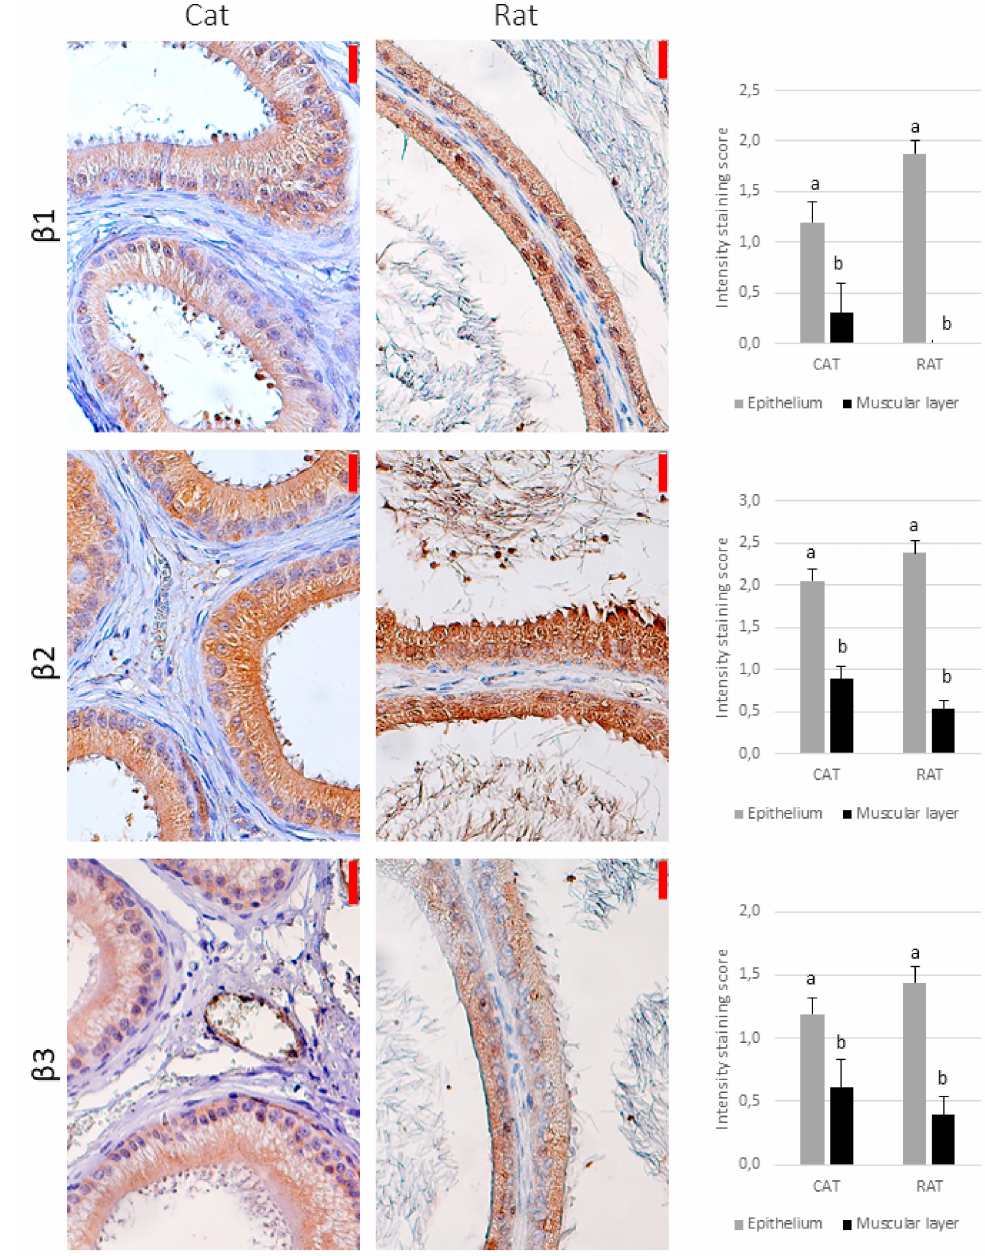
Figure 4. The immunohistochemical localization of the β -adrenoceptors in the feline and rat re- productive tract − representative pictures of the epididymis (counterstained with hematoxylin, magnification 400 × ). The red bar on the upper right of each image represents 20 µ m. The graphs on the right present the average reaction intensity score ( n = 6). Because of the lack of difference between the regions for most of the receptors investigated, the data are shown as the average intensity of staining for the regions analyzed and SEM, for the sake of clarity. The different letters above the bars (a,b) indicate significant ( p < 0.05) differences between the epithelium and muscular layer within a species. No significant differences between the species were